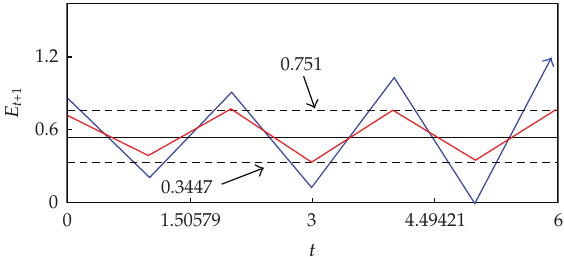
Figure 6: Time evolution of E with three di ff erent initial conditions: E (cid:5) 0 (cid:6) (cid:8) 0 . 532 (cid:5) the unstable steady state (cid:6) , E (cid:5) 0 (cid:6) (cid:8) 0 . 63 (cid:5) trajectory converging to the 2-period stable limit cycle (cid:6) , and E (cid:5) 0 (cid:6) (cid:8) 0 . 862 (cid:5) trajectory diverging from the unstable 2 period limit cycle (cid:6)